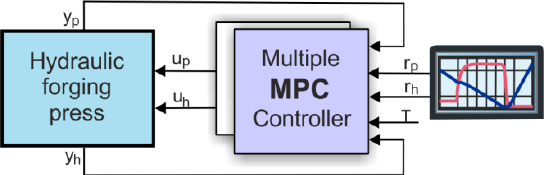
Figure 12. Block diagram of the structure of a model predictive control for a hydraulic forging press.